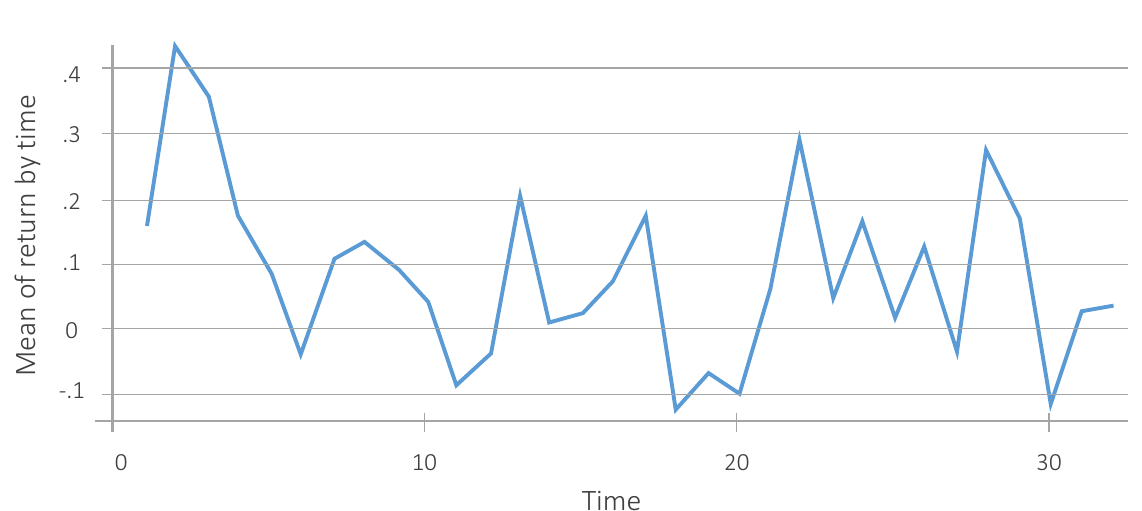
Figure 1. Heterogeneity across units